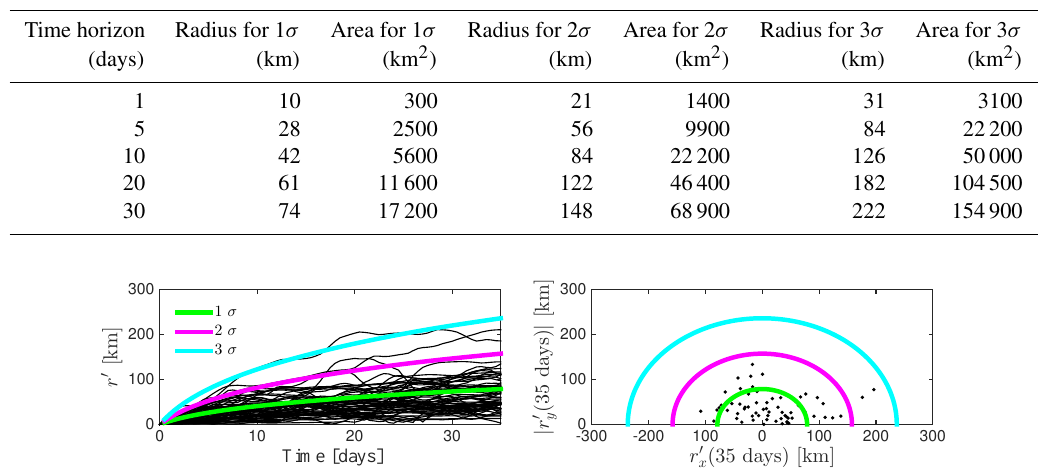
Table 2. This table gives an estimate of the search radii and areas corresponding to 1, 2 and 3 standard deviations, respectively, and for time horizons ranging from 1 to 30 days. These numbers are averaged over the whole domain and period analyzed in Sect. 2 and should be reevaluated for specific applications, periods and domains of interest, for example by using model outputs having passed the evaluation test proposed in Sect. 3. Note that we checked that about 67, 96 and 99.6% of the fluctuating displacements are smaller than 1, 2 and 3 standard deviations.